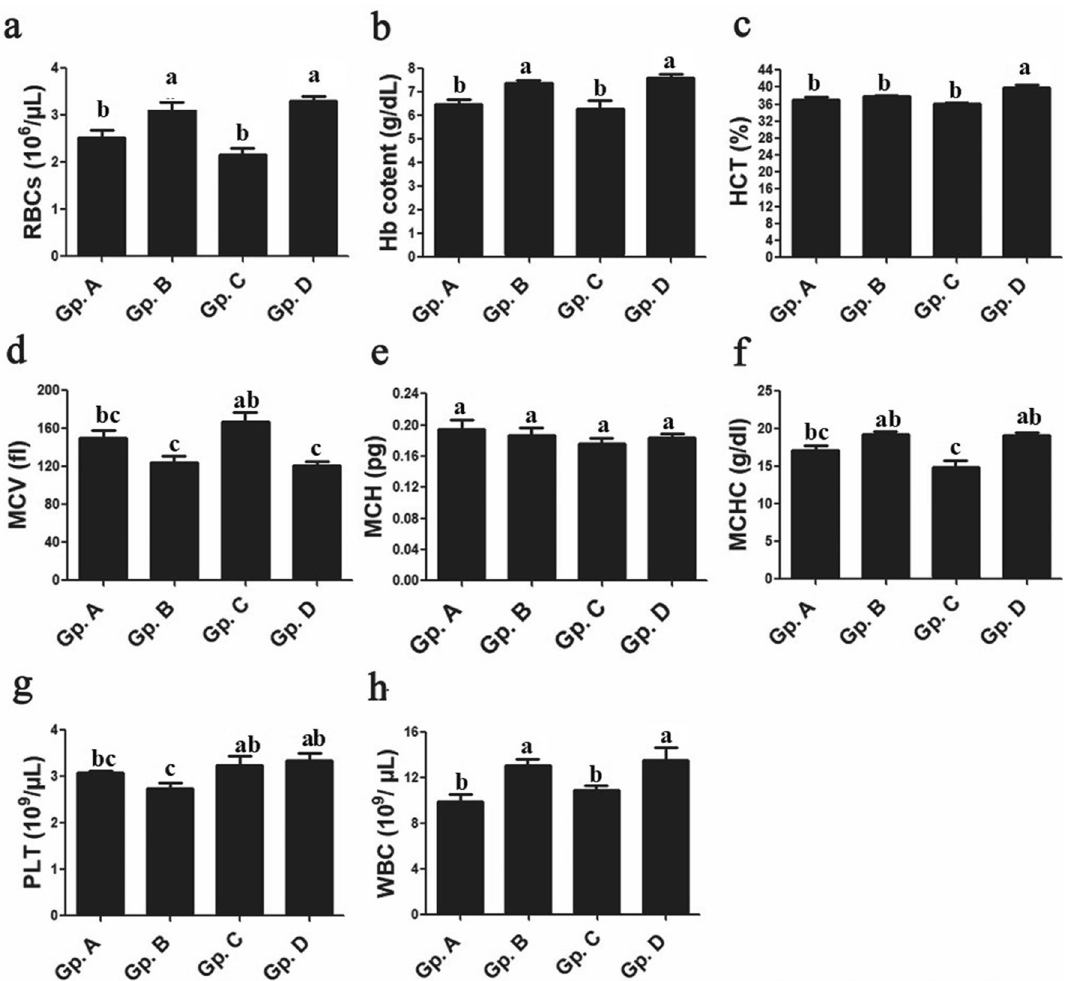
Figure 2. Effect of temperature changes on some haematological parameters ( a : RBCs; b : Hb; c : HCT; d : MCV; e : MCH; f : MCHC; g : PLT; h : WBC) in the different experimental groups of Dabb lizard ( U. aegyptia ). Data were expressed as mean ± SE. Gp. A: control group; Gp. B: low temperature exposed group; Gp. C: moderate temperature exposed group; Gp. D: high temperature exposed group; RBC: red blood corpuscles; Hb: haemoglobin concentrations; HCT: haematocrit value; MCV: mean corpuscular volume; MCH: mean corpuscular haemoglobin; MCHC: mean corpuscular haemoglobin concentration; PLT: platelets; WBC: white blood cell. abc Means above each bar with different letters in different Dabb groups i.e. Gp. A, Gp. B, Gp. C and Gp. D, were significantly different (P <